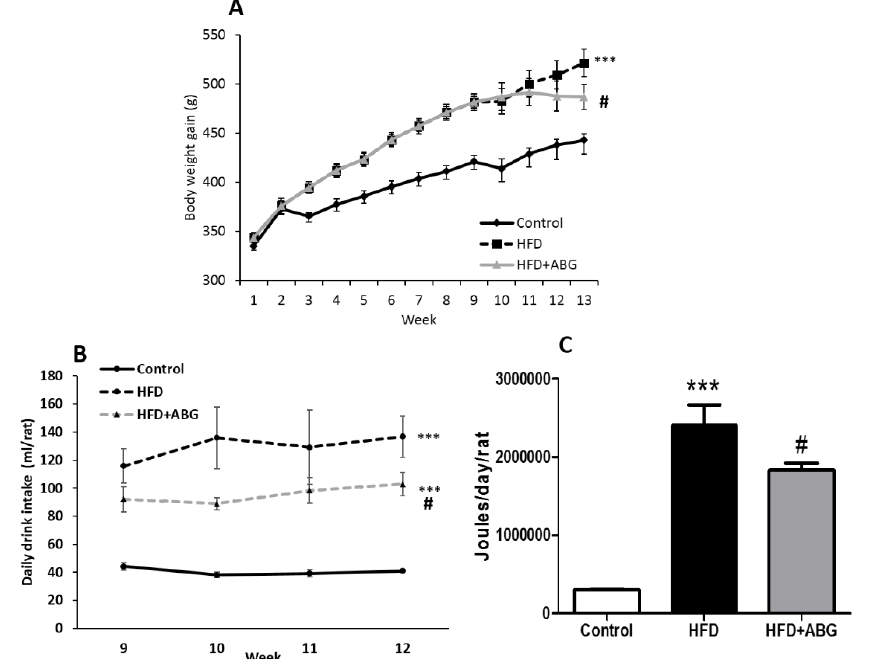
Figure 2. Body weight gain ( A ), mean daily drink intake ( B ), and mean daily caloric intake ( C ) of rats fed a standard chow (control) or a high-fat/sucrose diet (HFD) and treated with vehicles or HFD + ABG. Data are represented as mean value ± SEM; n = 12 rats/group. *** p < 0.01 vs. control; # p < 0.05 vs. HFD. Table 2. Organ weights, lipid profile and hormone concentrations in the serum of rats fed a standard chow (control) or a high-fat diet (HFD)/high-sucrose diet and treated with vehicles or HFD + ABG.